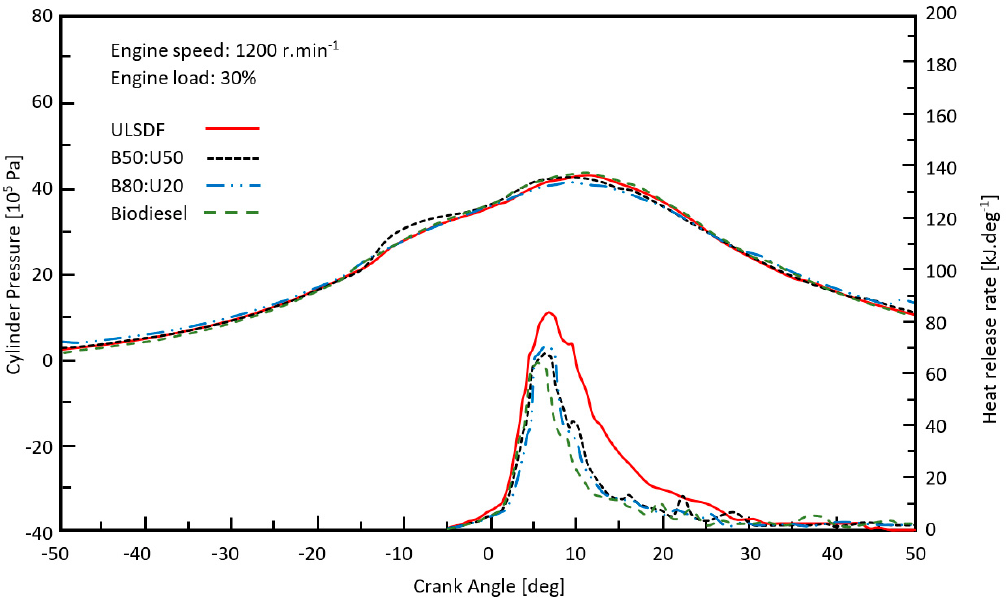
Figure 2. Tested fuels’ influence on the heat release rate and cylinder pressure at 1200 rpm and 30% load.